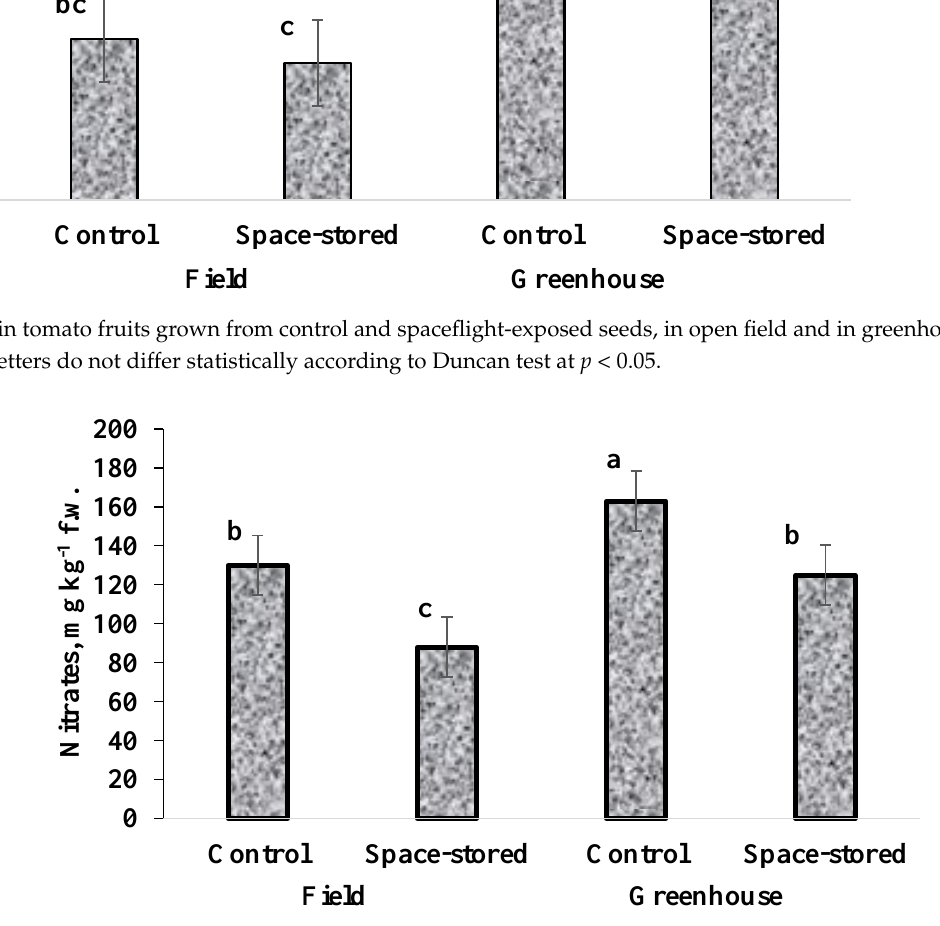
Figure 2. Nitrate accumulation in tomato fruits grown from control and spaceflight-exposed seeds, in open field and in greenhouse. Values with the same letters do not differ statistically according to Duncan test at p < 0.05.